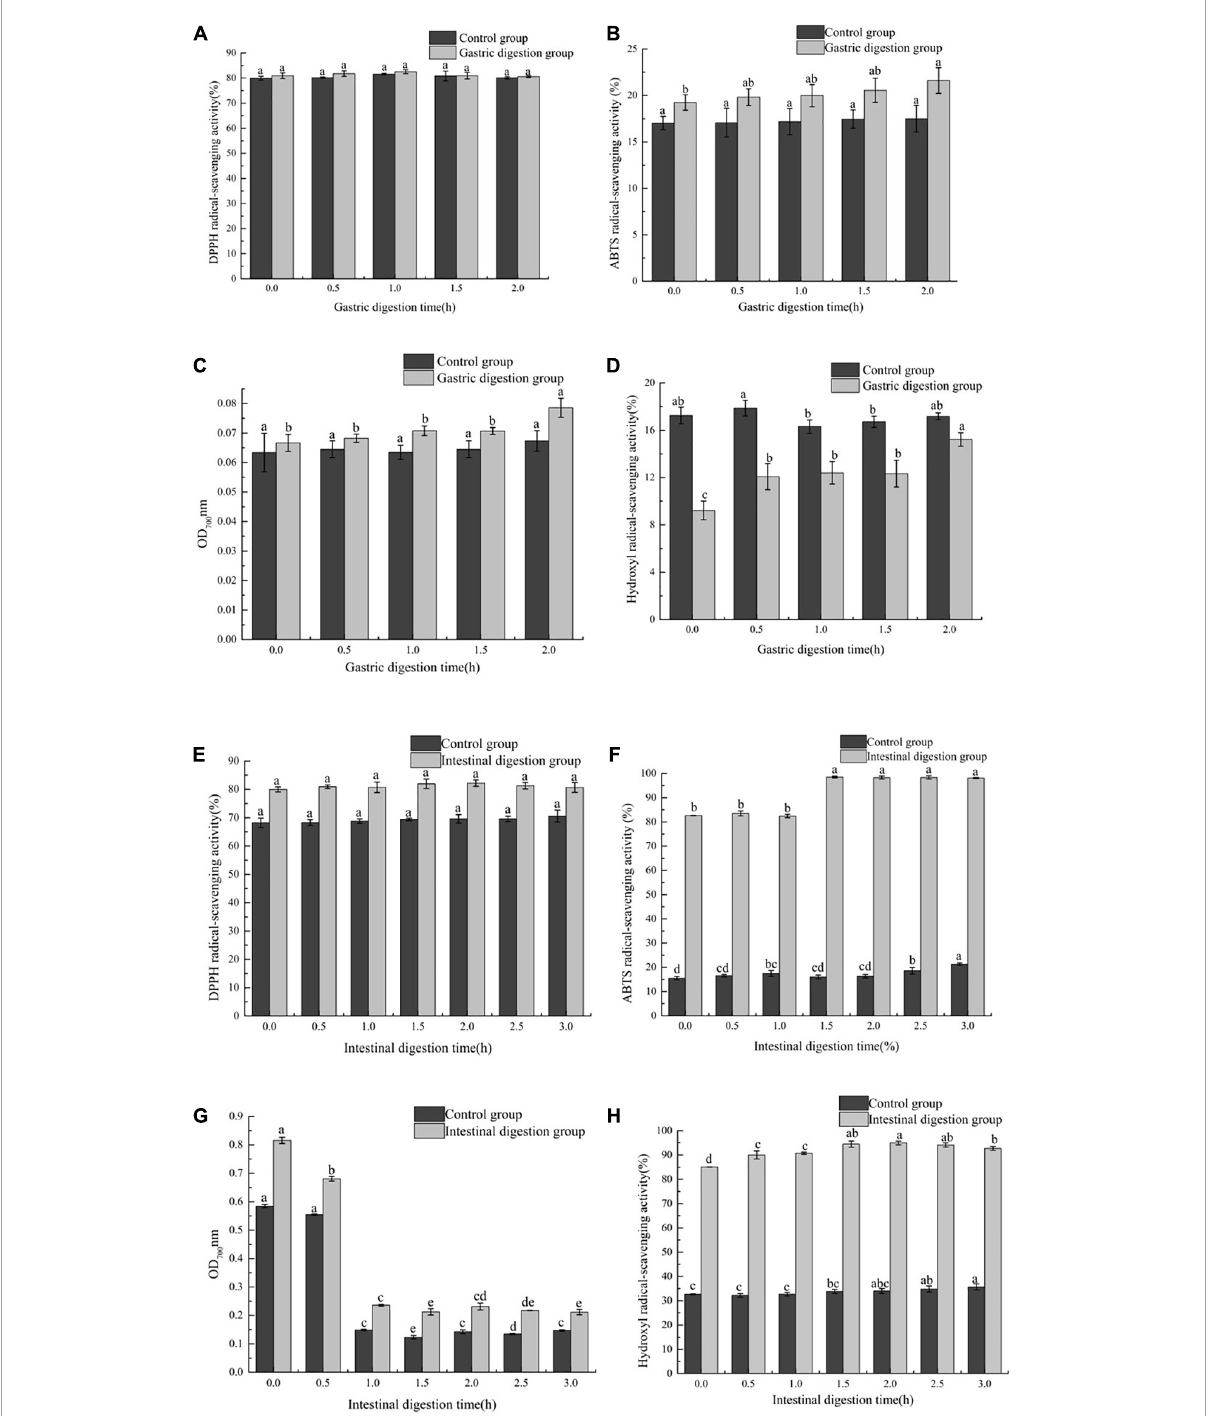
FIGURE2 The effect of in vitro gastrointestinal (GI) digestion on antioxidant activity. (A) The effect of in vitro gastric digestion on DPPH radical-scavenging activity, (B) the effect of in vitro gastric digestion on ABTS radical-scavenging activity, (C) the effect of in vitro gastric digestion on Fe 3 + reducing power, (D) the effect of in vitro gastric digestion on Hydroxyl radical-scavenging activity, (E) the effect of in vitro intestinal digestion on DPPH radical-scavenging activity, (F) the effect of in vitro intestinal digestion on ABTS radical-scavenging activity, (G) the effect of in vitro intestinal digestion on Fe 3 + reducing power, and (H) the effect of in vitro intestinal digestion on Hydroxyl radical-scavenging